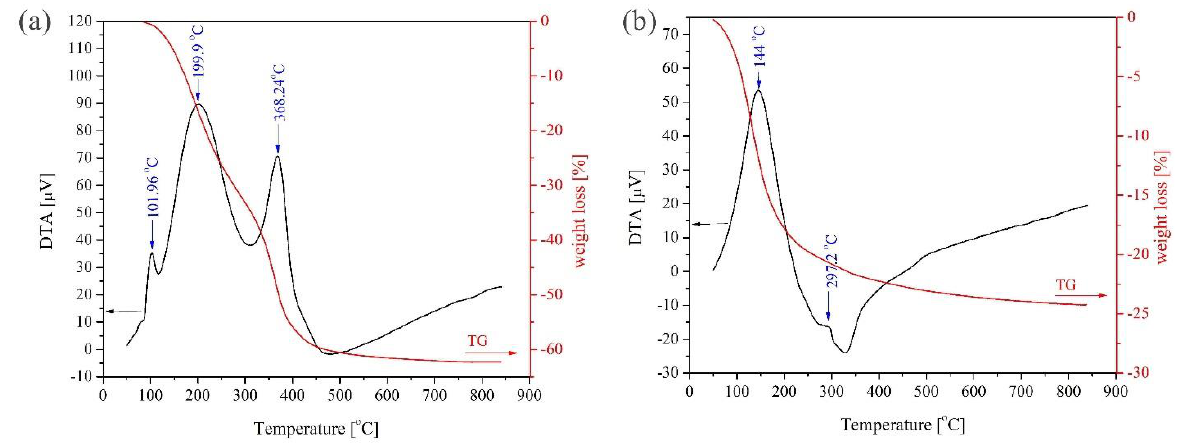
Figure 4. TG – DTA curves of powder: S1 ( a ) and S1FeSUB ( b ) (endothermic peaks are upward).